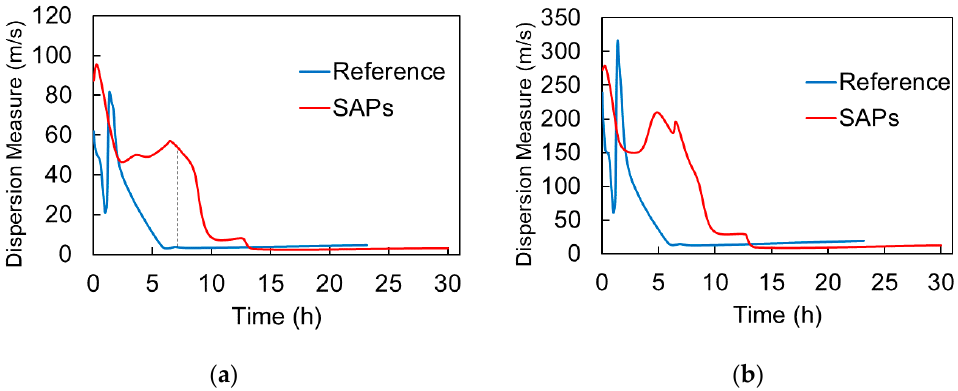
Figure 9. Dispersion measures vs. age of cement mortar, ( a ) standard deviation of the curve and ( b ) max–min difference of the curve for the band between 120 to 350 kHz.